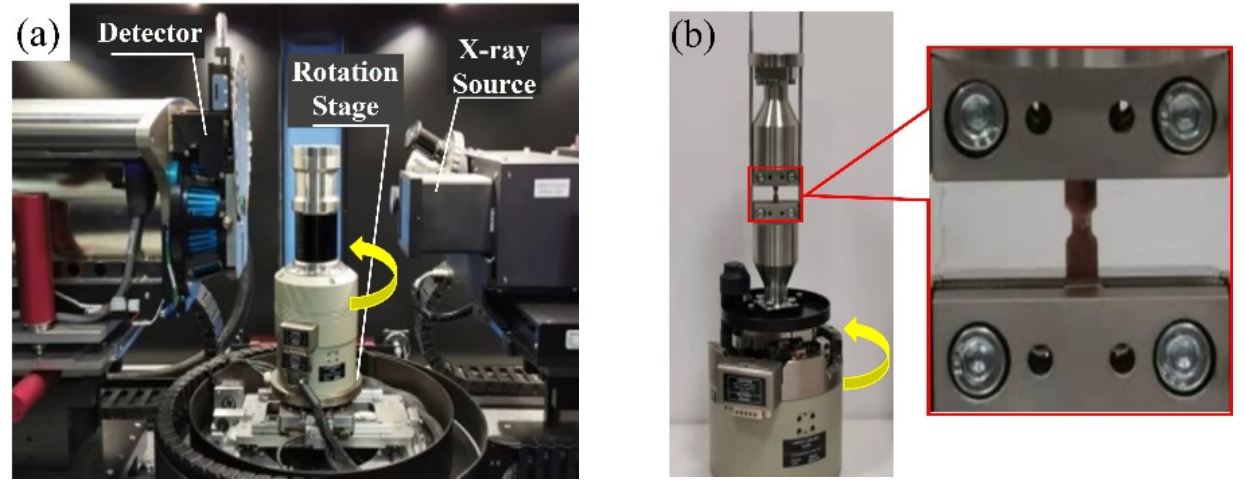
Figure 3. ( a ) Setup of in situ X-ray µ -CT; ( b ) tensile setup capable of rotating with µ -CT test piece table.